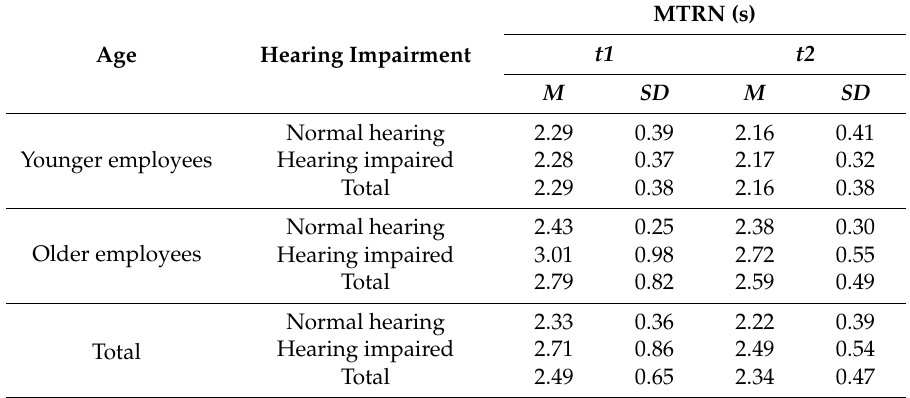
Table 4. Descriptive statistics—attention and concentration t1 and t2 : mean time correct rejection